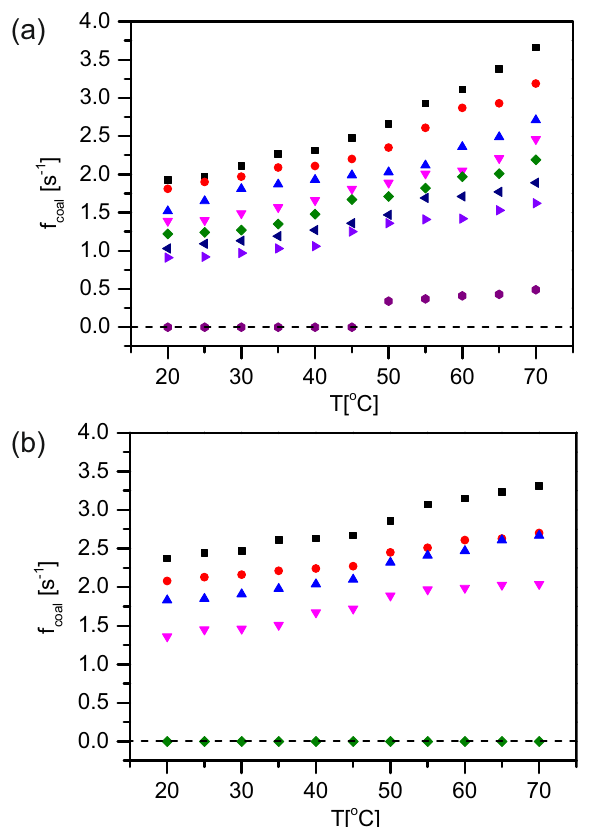
Figure 4. Coalescence trends at elevated temperatures for different ( a ) SDS, ( b ) Tween 20 concentrations. SDS concentrations are: 0.01 mM (black squares), 0.05 mM (red circles), 0.1 mM (blue upward triangles), 0.2 mM (pink downward triangles), 0.3 mM (green diamonds), 0.4 mM (dark blue leftward triangles), 0.5 mM (magenta rightward triangles), 1 mM (purple circles). For Tween 20 the concentrations are: 0.01 mM (black squares),